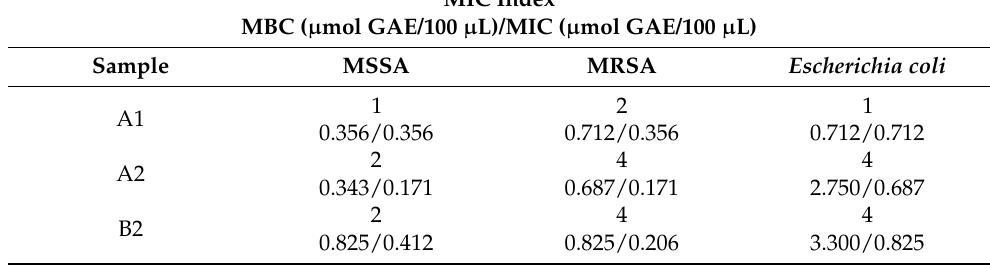
Table 5. In vitro antibacterial activity of the D. moldavica samples collected using broth microdilution